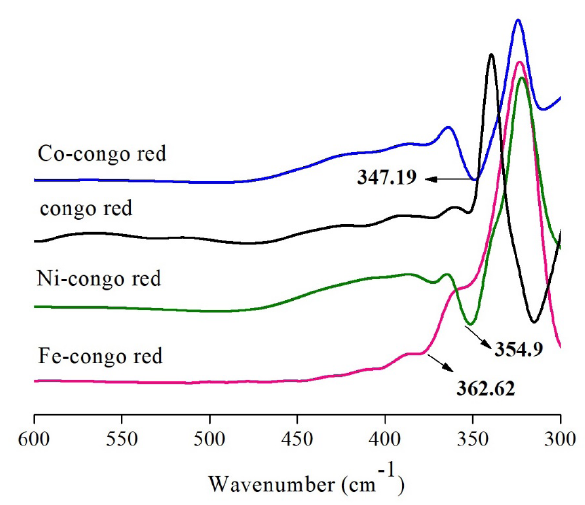
Figure 4: The determination of metal-ligand bonding of congo red complexes using FTIR.